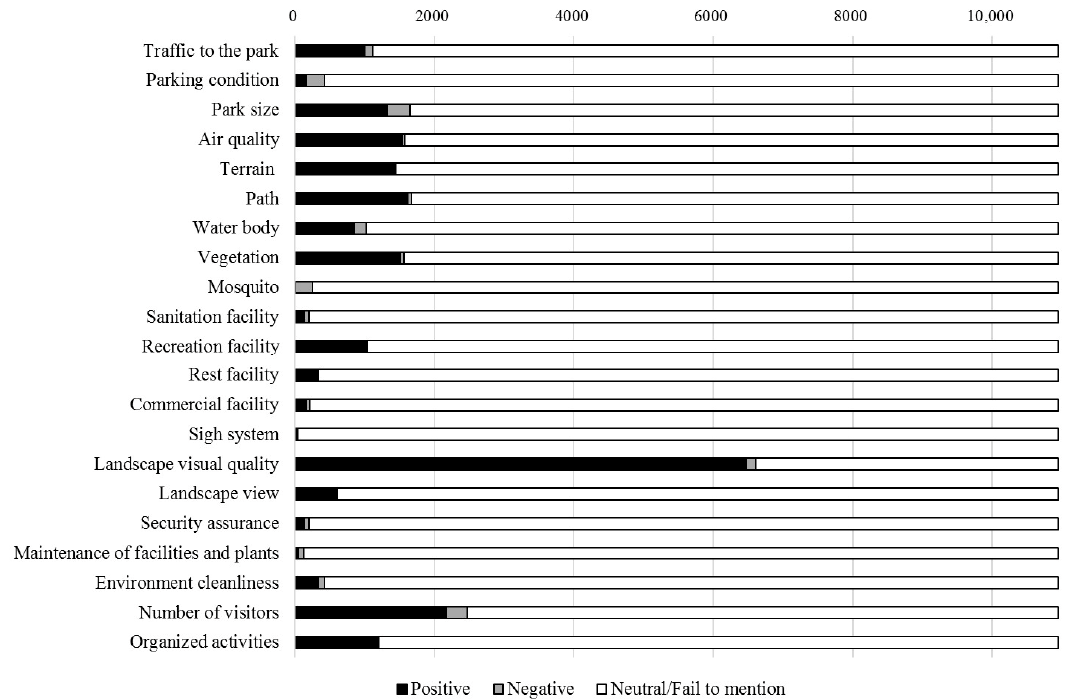
Figure 7. The number of online comments assigned to positive, negative and neutral emotions/fail to mention each factor.